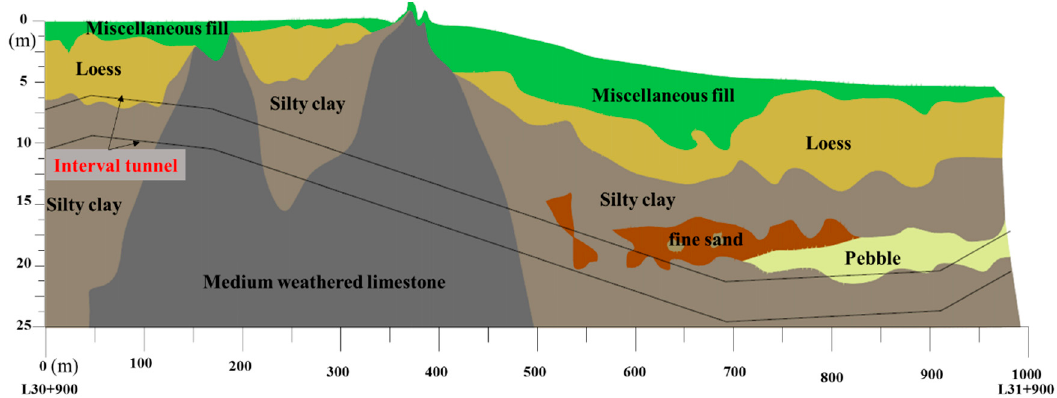
Figure 9. Geologic profile of the distance between the Wangfu village station and the Dayang village station.